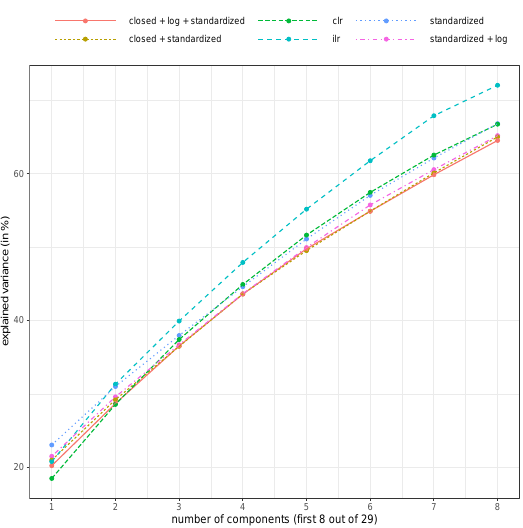
Figure 4. Explained variance (in %, cumulative) for different numbers of components and different pre-processing of the compositional saffron samples. Abbreviations as for Figure